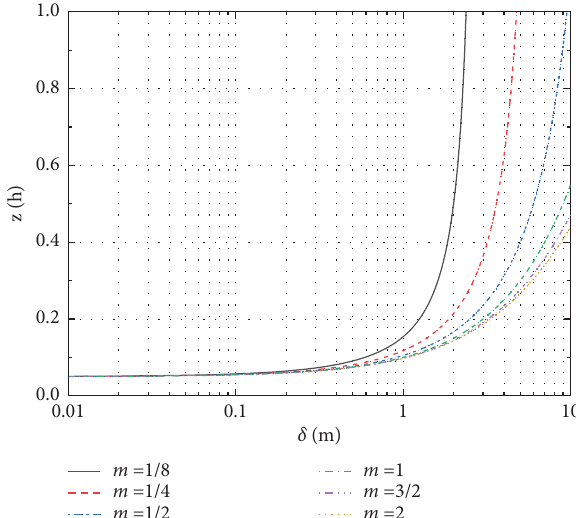
Figure 2: Teoretical distribution of the δ ( m ) function with dif- ferent m values.